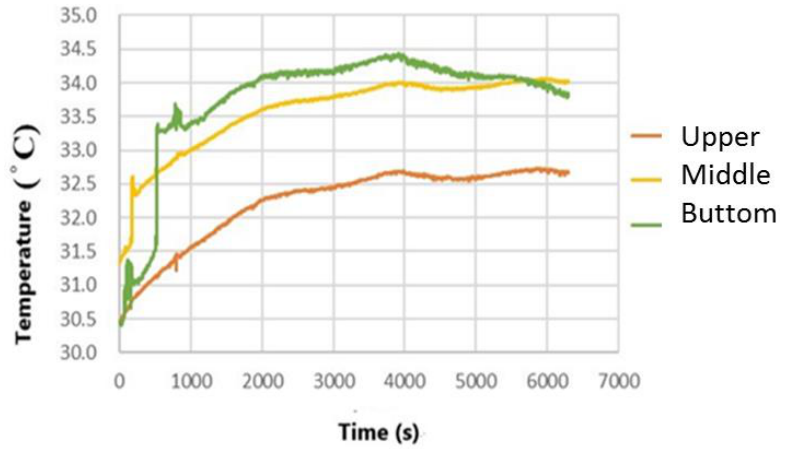
Figure 15. Runner current density curve.